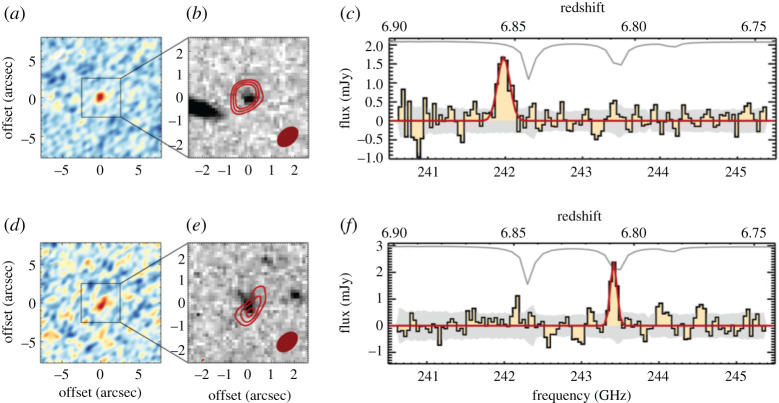
ALMA provides spectroscopic confirmation of the redshift of two Lyman-break galaxies with photometric redshifts in the range 6.6 < z < 6.9 via detection of the [CII] line. Panels (a,d) show the ALMA Band 6 observations averaged, panels (b,e) show the ALMA line-averaged contours overlaid on deep HST optical imaging at 1.6 μm, and panels (c,f) show the ALMA spectra of the [CII] lines. Figure reproduced from Smit et al. [289].